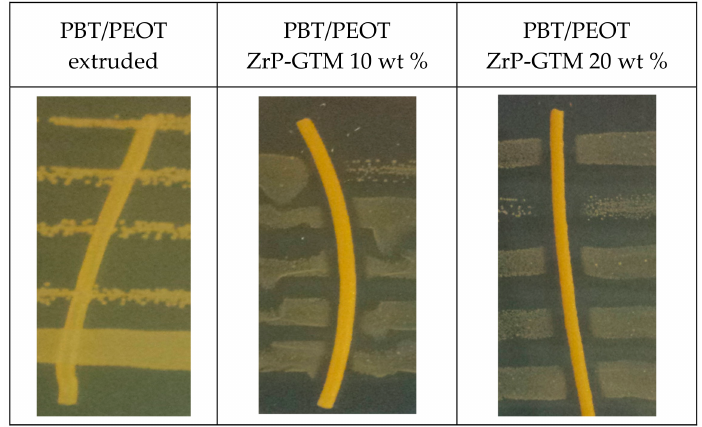
Figure 7. Photos of the indicated samples after the AATCC145 antimicrobial tests: ( left ) pure PBT/PEOT; ( center ) PBT/PEOT ZrP-GTM 10 wt % and ( right ) PBT/PEOT ZrP-GTM 20 wt